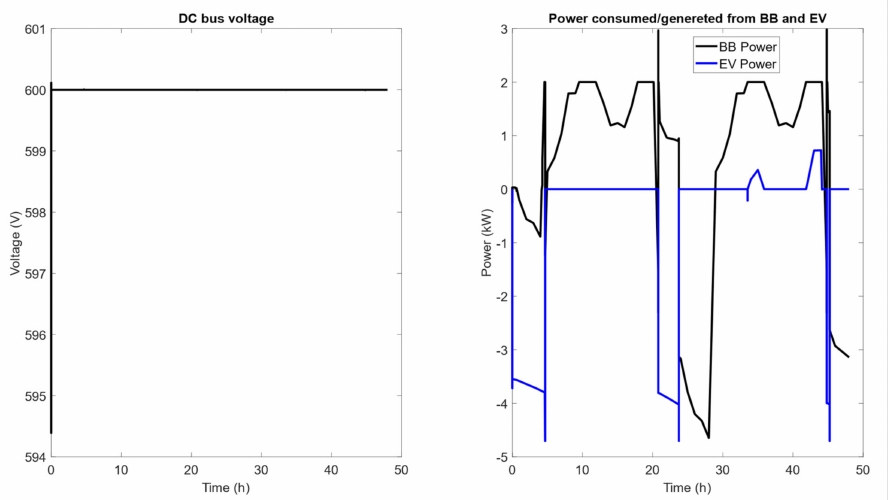
Figure 19. ( left ) DC bus voltage and ( right ) energy supplied (positive) and returned to the battery of the EV (red) and Battery Bank (black) in